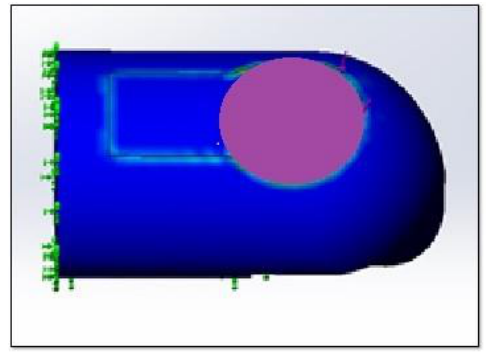
Figure 5. The fingertip silicon bay and the two geometrical parameters, namely the radius and depth of the sensor housing.